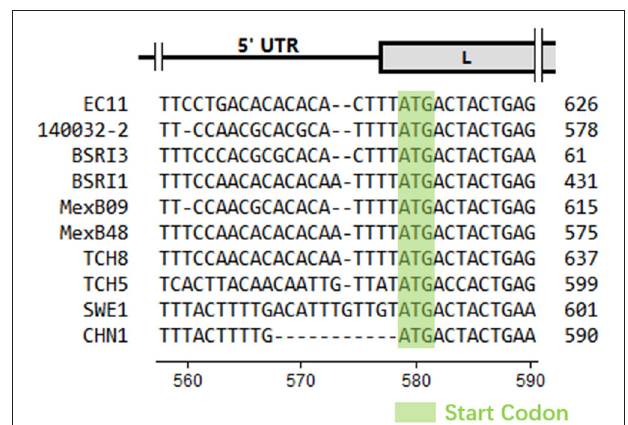
FIGURE 1 | Partial nucleotide alignment of CHN1 with reference sequences. The absence of nucleotides was represented by a dot. The scale of genomic regions was illustrated according to EC11 predicted in a previous study (18) and the position scale was indicated for CHN1. Start codons were indicated with a light green